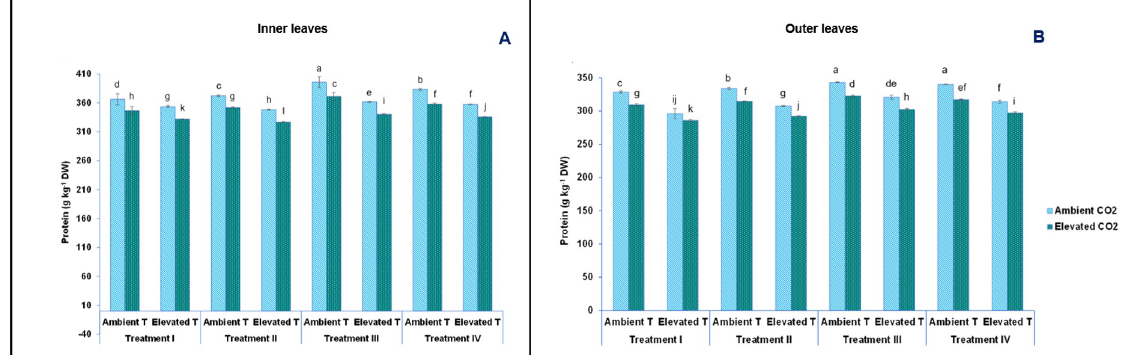
Fig 6. Effect of short-term heat stress on protein content (g kg -1 DW) in inner (A) and outer (B) leaves of the baby-leaf lettuce cv Derbi at two different levels of CO 2 and at four different NO 3- / NH 4+ treatments. Different letters are significantly different according to Tukey’s test at p � 0.05.